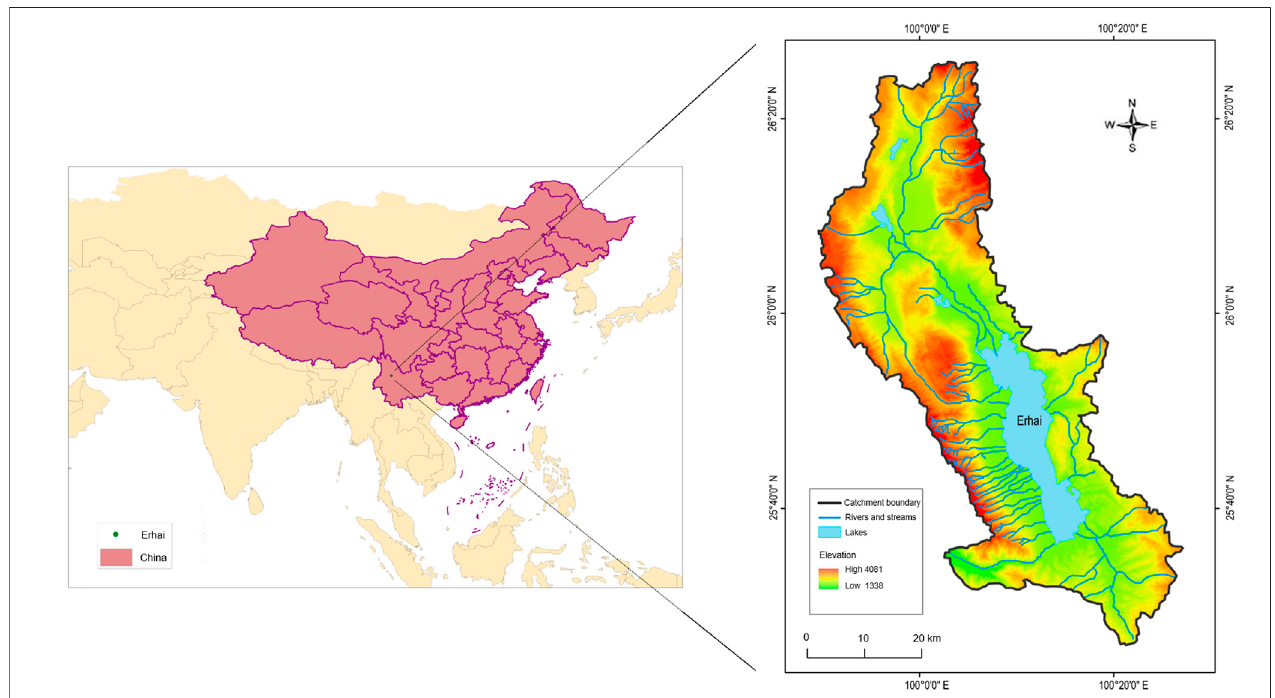
FIGURE 1 | Location of Erhai Lake in Yunnan, China, and catchment